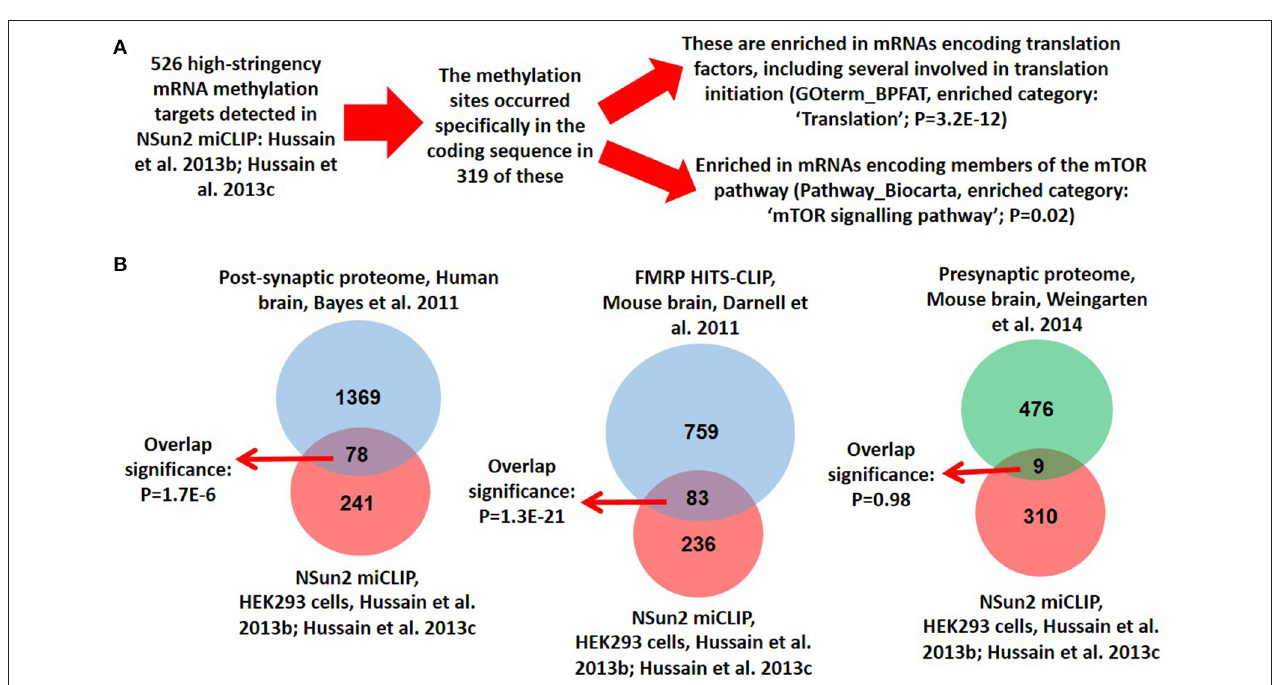
FIGURE 2 | Analysis of NSun2 mRNA methylation targets. (A) Methylation-individual-nucleotide-resolution-crosslinking-immunoprecipitation (miCLIP) was previously used to determine the transcriptomic RNA methylation targets of NSun2 in HEK293 cells ( Hussain et al., 2013b). Most NSun2 methylation sites occurred within the coding sequence of mRNAs, and 319 of these were identified (Hussain et al., 2013b,c); these are found to be enriched in mRNAs encoding translation factors as well members of the mTOR signaling pathway. Gene Ontology analysis and calculation of P -values for enrichment was performed by the DAVID Bioinformatics Resource. Full gene lists available in Supplementary Table 1 . (B) The 319 NSun2 mRNA methylation targets from HEK293 cells were compared with the 1461 members of the postsynaptic proteome from the human neocortex (Bayés et al., 2011), the 842 FMRP mRNA binding targets from the mouse brain (Darnell et al., 2011), and the 485 members of the pre-synaptic proteome from the mouse brain (Weingarten et al., 2014). Full gene lists available in Supplementary Table 1 . Considering the shared expression of > 90% of mRNAs between HEK293 cells and brain (Su et al., 2004), and using a conservative approximation of 10,000 protein coding genes expressed in each (Ramsköld et al., 2009), a hypergeometric test was used to calculate the significance of the degree of overlap observed between the targets.